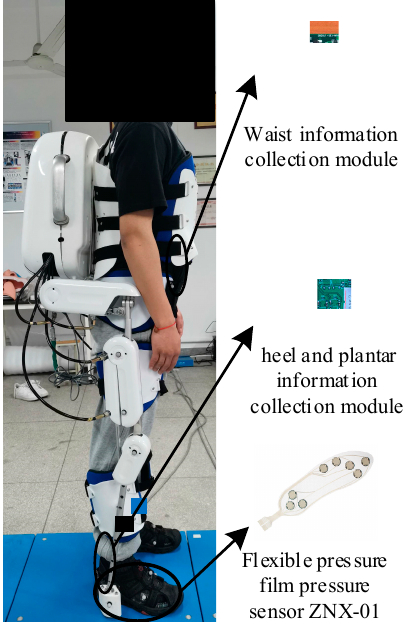
Figure 4. Sensor information acquisition configuration.